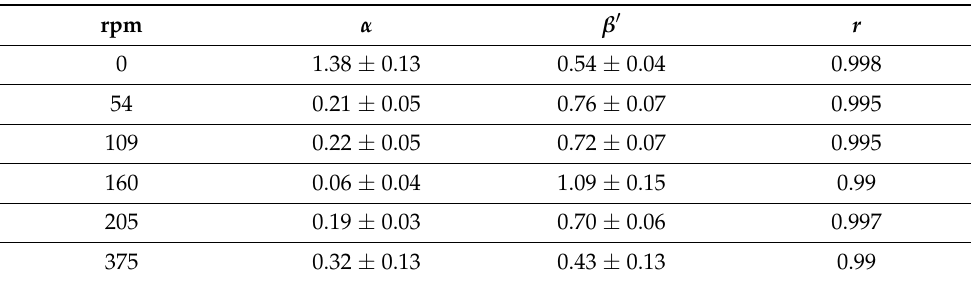
Table 5. Parameters α (10 − 5 Am − 2 K − 1 ) and β ’ , and regression coefficient r (from fitting experimental data in Figure 7a to Equation (8)) at 25 ◦ C.